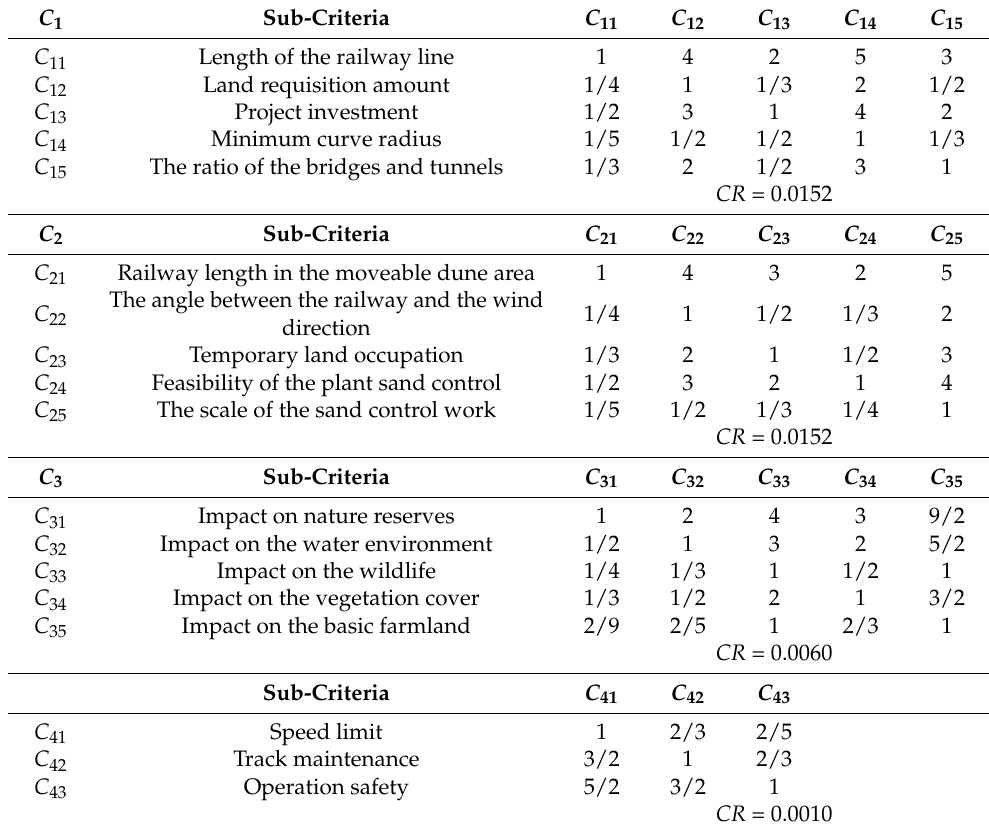
Table 4. The judgment matrix of the second-level